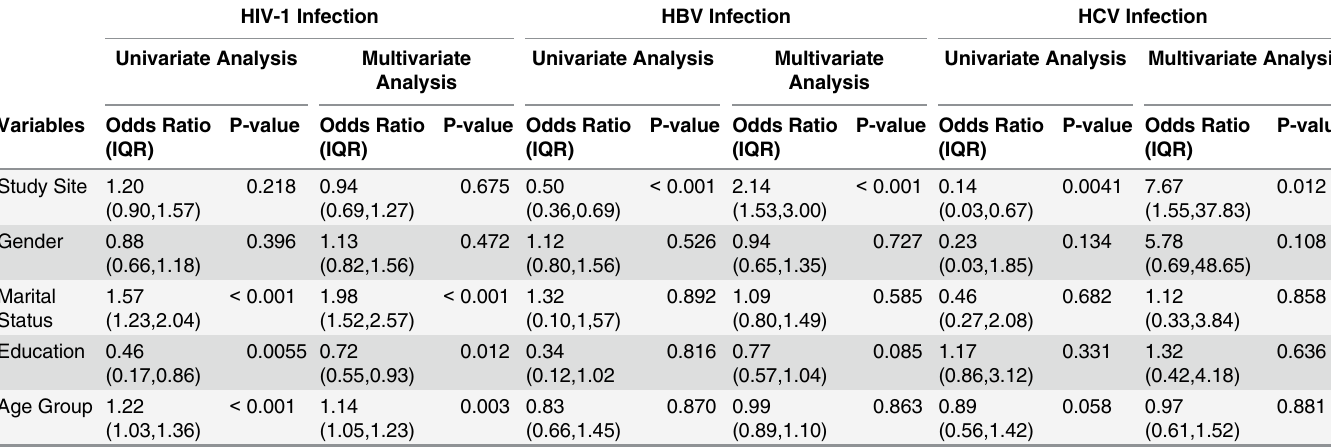
Table 3. Multivariate analysis between HIV, HBV, HCV and sociodemographic